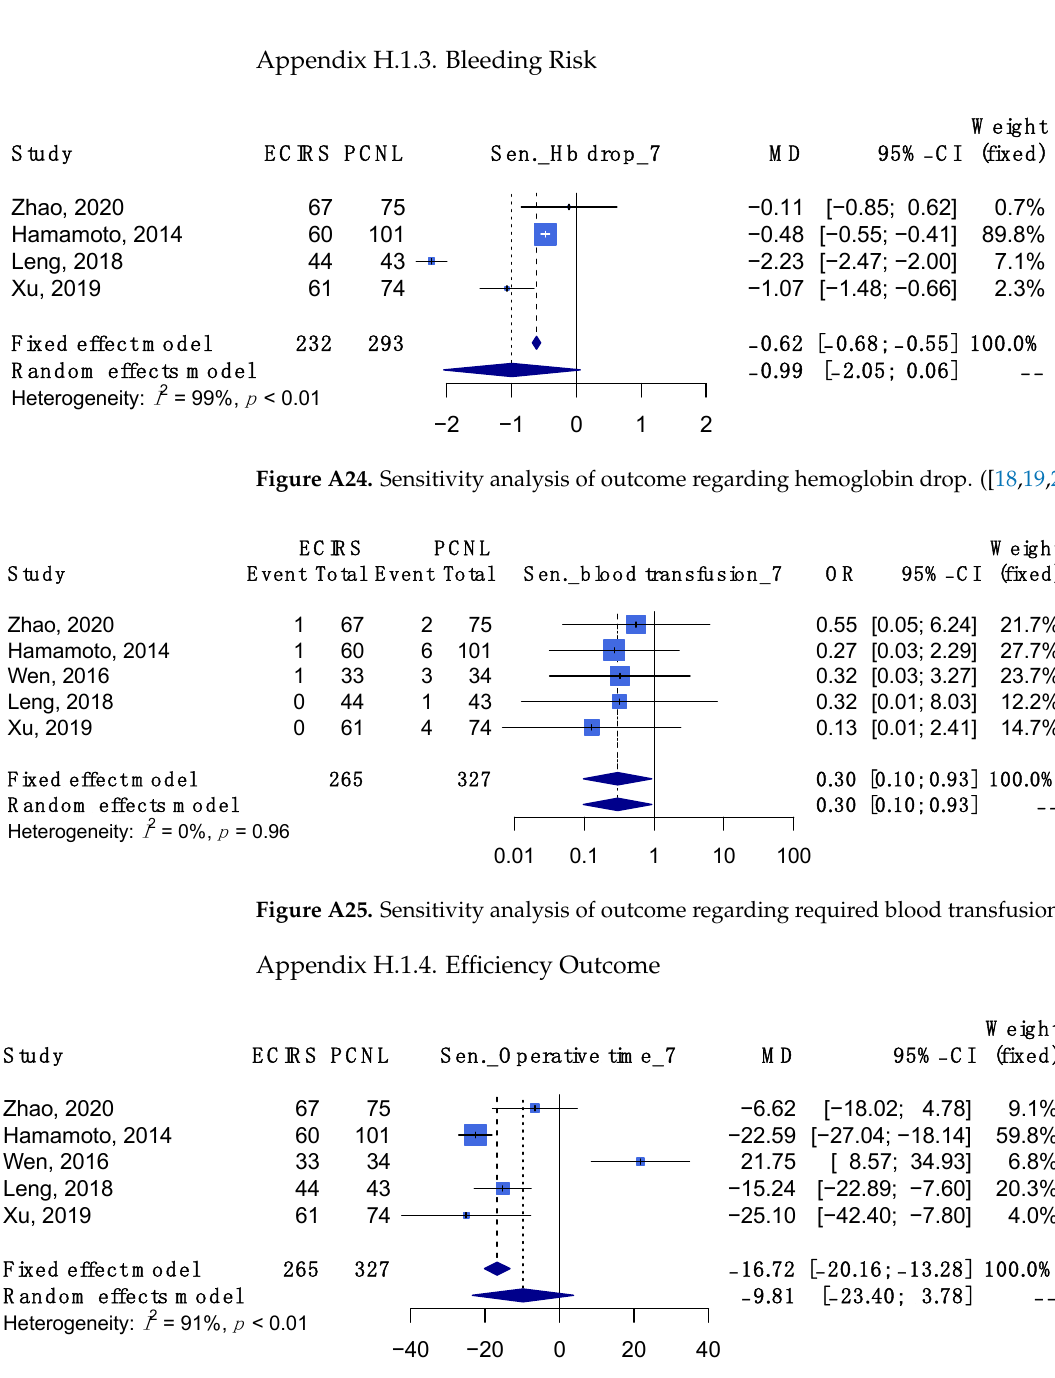
Study Fixed effect m odel R andom effects m odel Heterogeneity: I 2 = 0%, p = 0.87 Zhao, 2020 Hamamoto, 2014 Wen, 2016 Leng, 2018 Xu, 2019